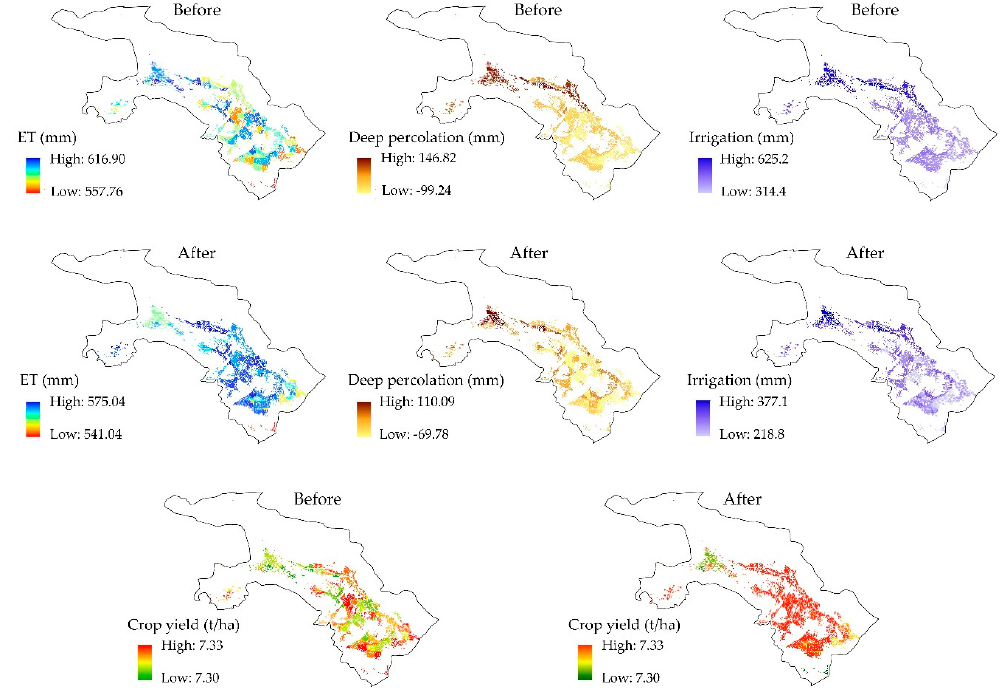
Figure 8. Distribution of annual evapotranspiration (ET), deep percolation, irrigation amount and crop yield during 2001 to 2010 in maize land before and after irrigation optimization conditions.